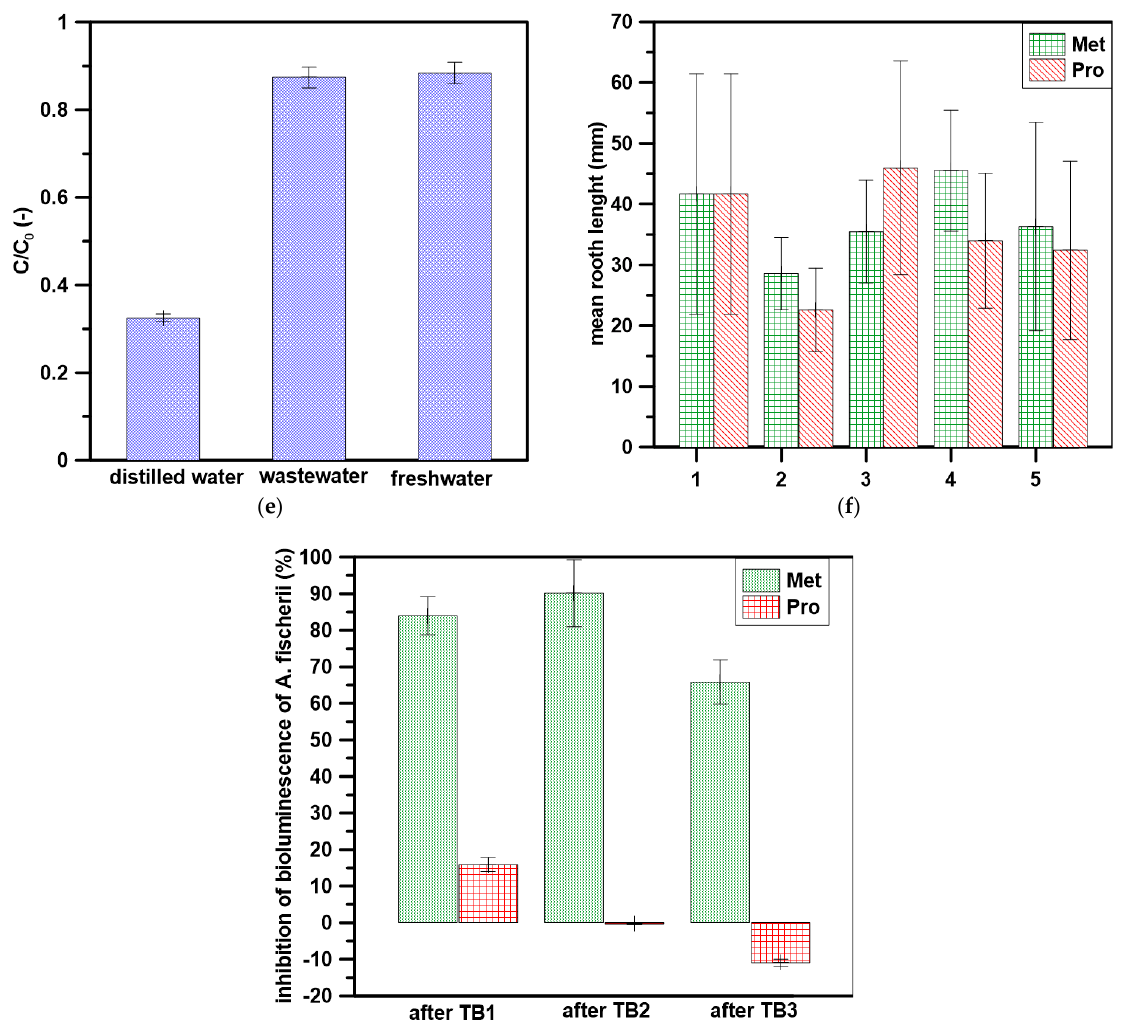
Figure 4. The removal of Met and Pro: ( a ) Met removal kinetics, inside: pseudo-first-order fitting; ( b ) Pro removal kinetics, inside: pseudo-first-order fitting; ( c ) DOM effect; ( d ) inorganic ions effect [c 0 = 0.001 M]; ( e ) effect of water matrix; ( f ) PHYTOTOXKIT test results; ( g ) Microtox ® test results. Table 1. The physicochemical properties of tested materials.